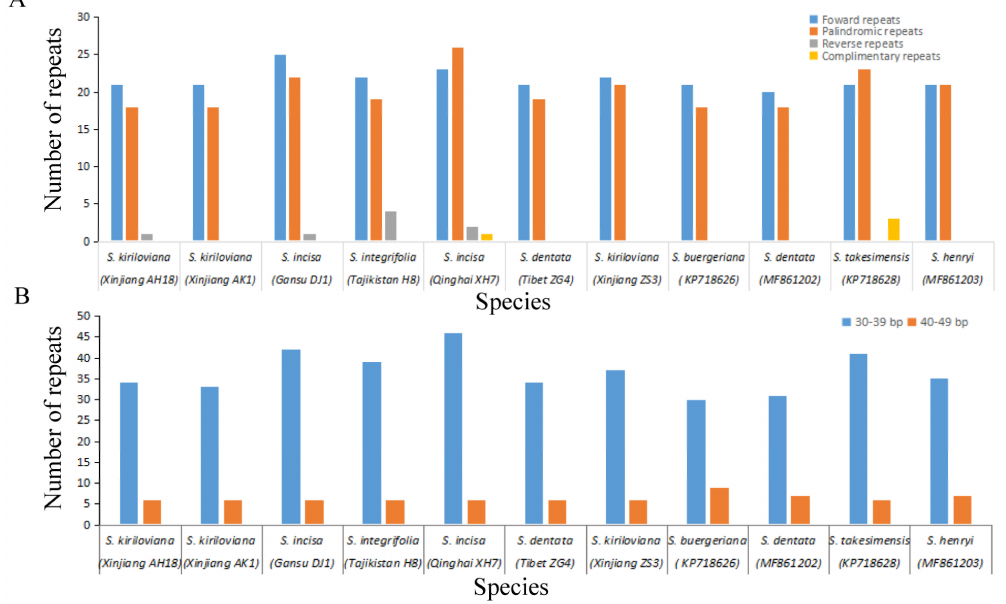
Figure 6. Repeat analyses in eleven chloroplast genomes of Scrophularia . ( A ) Frequency of repeat types. ( B ) Frequency of repeats by length.